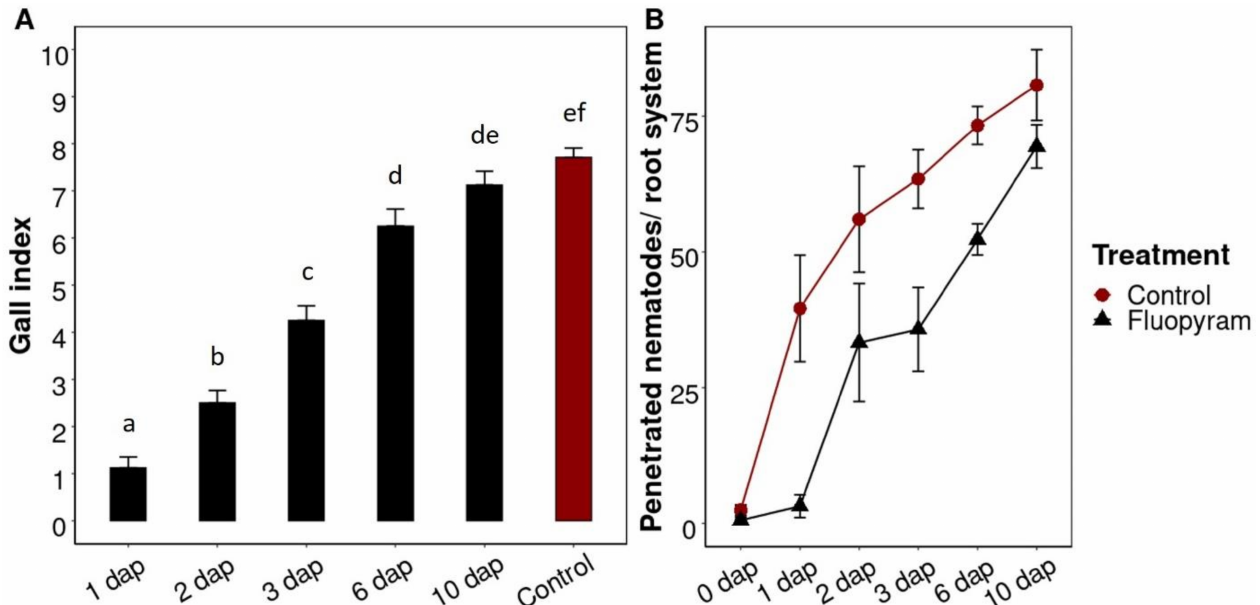
Figure 3. Meloidogyne incognita second-stage juveniles controlling effect of fluopyram at different application time points, 0, 1, 2, 3, 6 or 10 days after planting (dpa). ( A ) The root gall-index was rated according to Zeck’s scale of root-knot infection [19]. ( B ) The number of M. incognita J2s that successfully penetrated tomato roots one day after each fluopyram treatment (n = 7). Initial M. incognita suspension of 150 J2s/plant. Different letters over the bars indicate significant differences compared to the control according to a one-way ANOVA with post-hoc Tukey HSD test ( p ≤